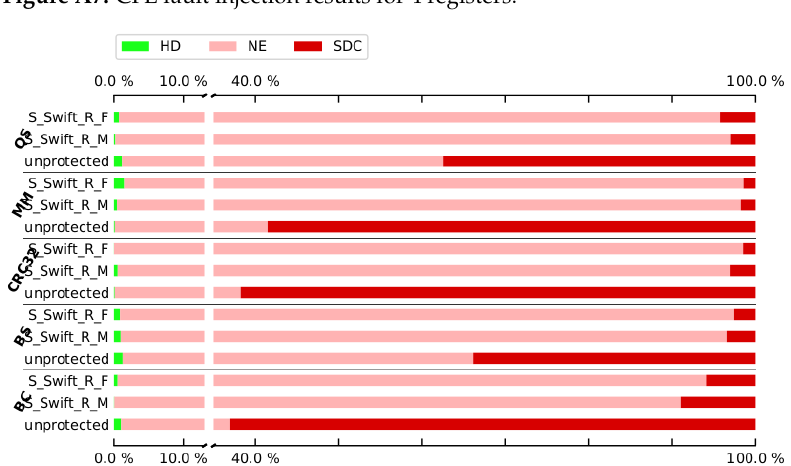
Figure A7. CFE fault injection results for 4 registers.